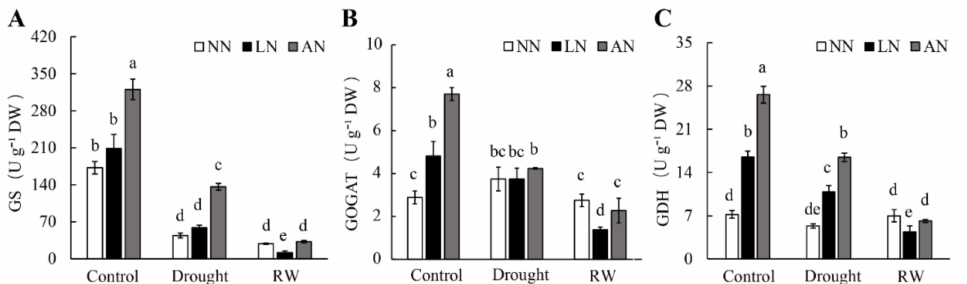
Figure 4. The effects of rhizobia inoculation on GS, GOGAT, and GDH activities in roots of Chinese milk vetch in response to drought stress. Ninety-day-old plants were withheld irrigation for 11 days (drought), followed by 2 days of rewatering (RW). Activities of GS ( A ), GOGAT ( B ), and GDH ( C ) in leaves were determined, while non-stressed plants were used as a control. AN, LN, and NN indicate the plants with active nodules, low-activity nodules, and no nodules, respectively. The data presented are means and standard errors of three replicates, and the same letter above the column indicates no significant difference at p <